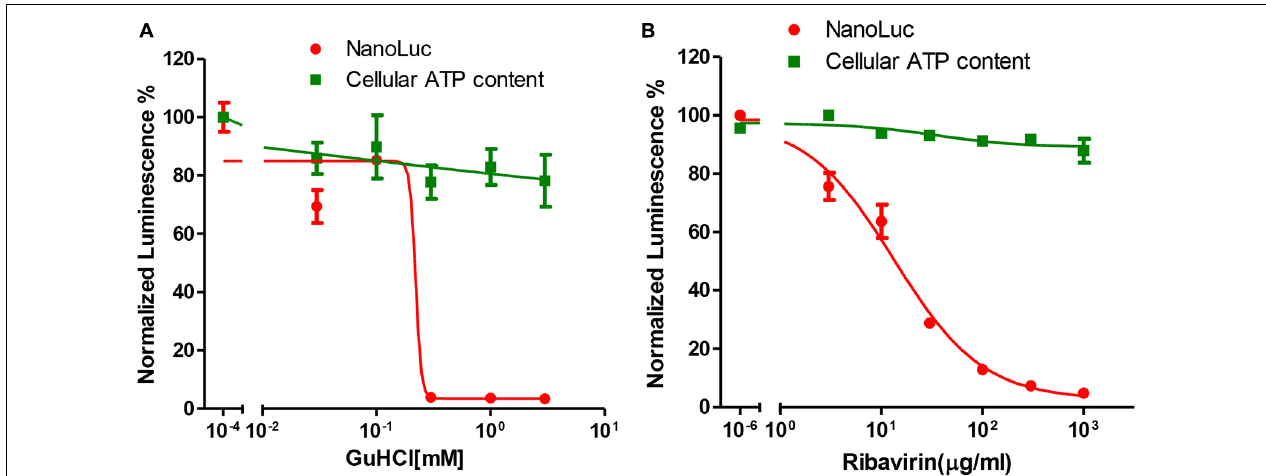
FIGURE 3 | Antiviral tests of GuHCl and Ribavirin with Nanoluc reporter virus. (A) RD cells infected with full-length EV71 reporter virus were treated with indicated concentrations of GuHCl and NanoLuc luciferase was determined 24 h post-infection. Cellular ATP content was determined with Cell Titer Glo to indicate the toxicity of this compound. (B) RD cells infected with full-length EV71 reporter virus were treated with indicated concentrations of Ribavirin and NanoLuc luciferase was determined 24 h post-infection. Cellular ATP content was determined with Cell Titer Glo to indicate the toxicity of this